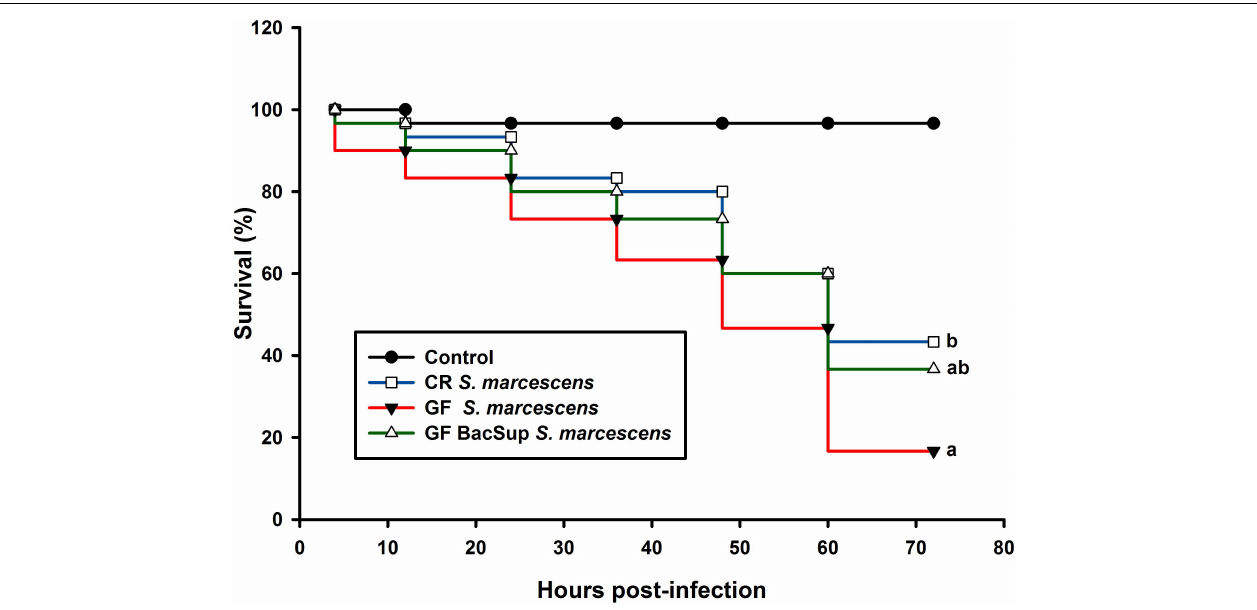
FIGURE 3 | Red palm weevil survival rate of RPW larvae after Serratia marcescens infection. The control (black line) insects were injected with sterile PBS. The symbiotic (CR, blue line and GF BacSup., green line) and aposymbiotic (GF, red line) individuals were injected with Serratia marcescens . Different alphabetic letters represent the significance (Kaplan Meier Survival analysis, Log rank test P < 0.05).